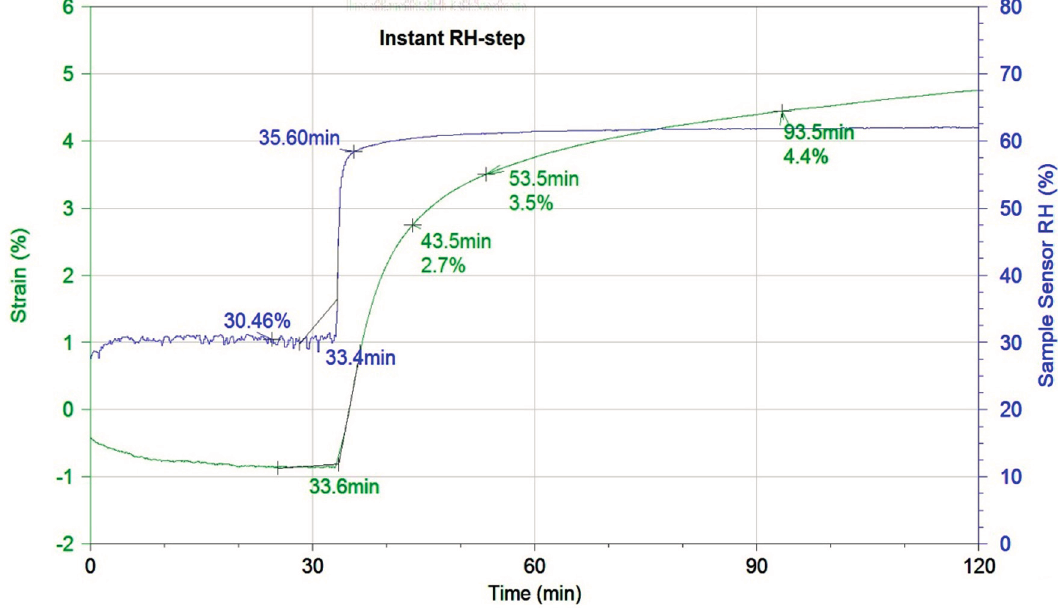
Figure 3. Instant RH-step at 20 °C, for a ~0.04 mm CaCas/Gly film stored at RH s = 50%: step from RH a = 30% to RH 1 = 62%. Legend: Blue = RH; Green = Strain% (sample